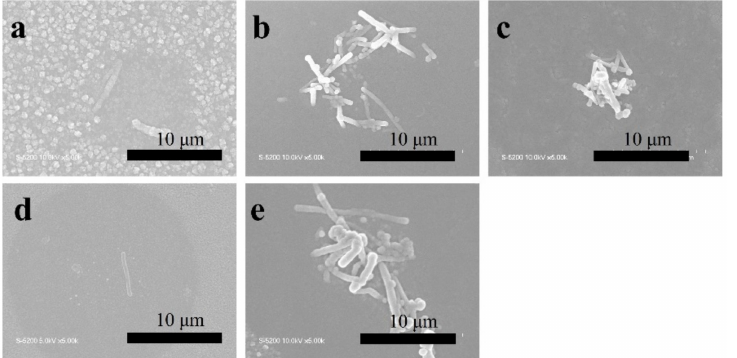
Figure 3. Elemental mapping of T-A and T-C-A.